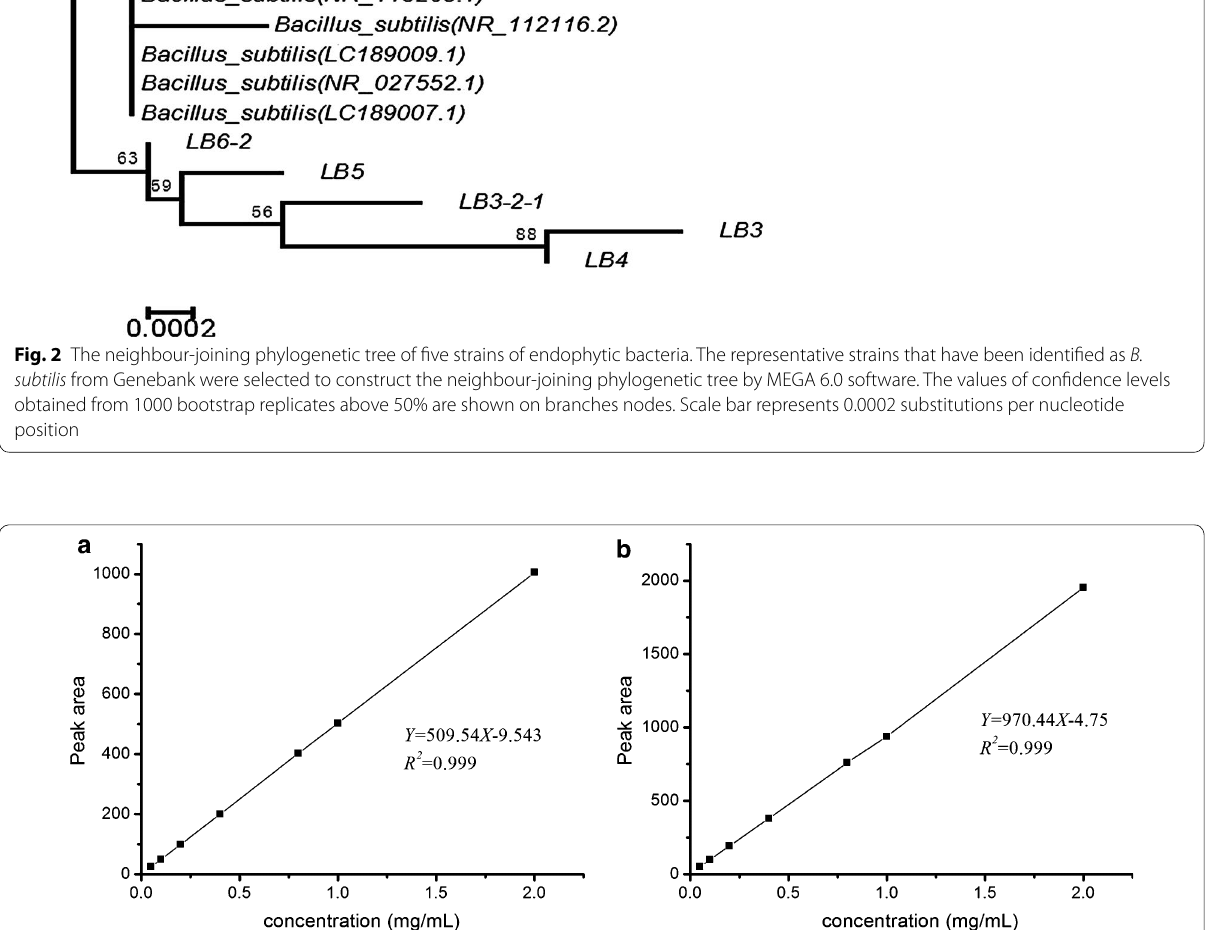
Fig. 3 Standard curves of authentic compounds. a standard curve of TMP, b standard curve of